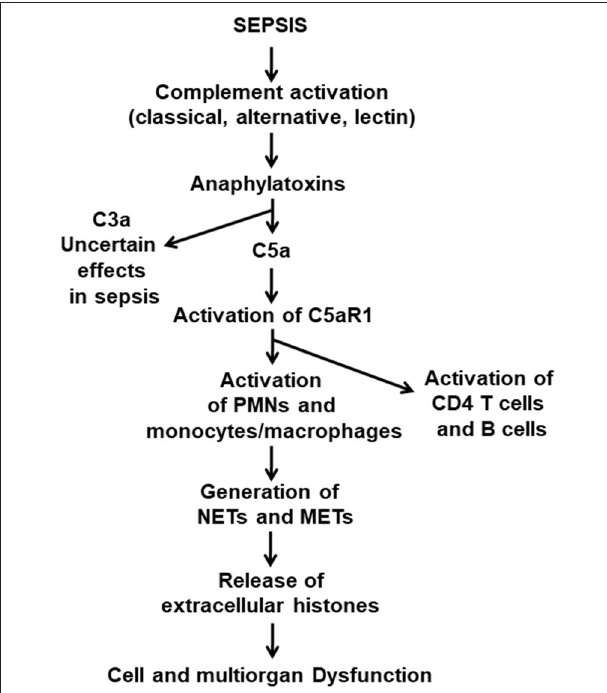
FIGURE 1 | Pathophysiological consequences of sepsis. This figure is a composite of what is currently known about the pathophysiology of polymicrobial sepsis in mice. Onset of sepsis is associated with activation of the three pathways of complement activation, which results in appearance of the anaphylatoxins, C3a and C5a. Both anaphylatoxins have strong proinflammatory effects, and both interact with their receptors, C3aR and C5aR1 and C5aR2, especially on PMNs and macrophages. The literature indicates that the C5a axis of activation, involving C5aR1 and C5aR2, causes proinflammatory responses that are harmful to cells and organs. In addition, C5a interaction with C5aR1 activates PMNs and monocytes and macrophages which form NETs and METs that are strongly proinflammatory and prothrombotic. Similar events occur in septic